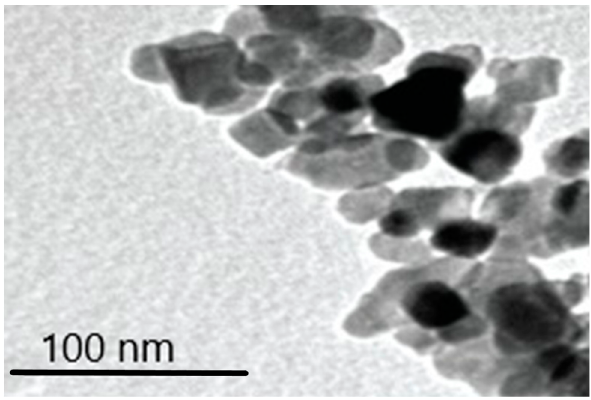
Figure 7. Typical transmission electron microscopy (TEM) micrograph of TiO 2 particles in plasma samples. Magnification bar = 100 nm.